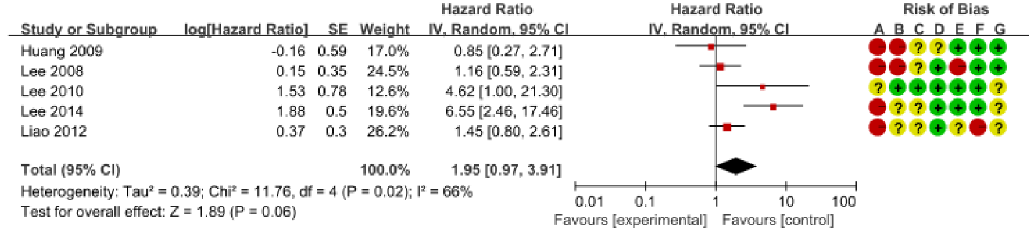
Fig 9. Forest plot of lymphovascular space invasion (-/+) and overall survival of small cell carcinoma of the cervix patients. SE: standard error; CI: confidence interval.